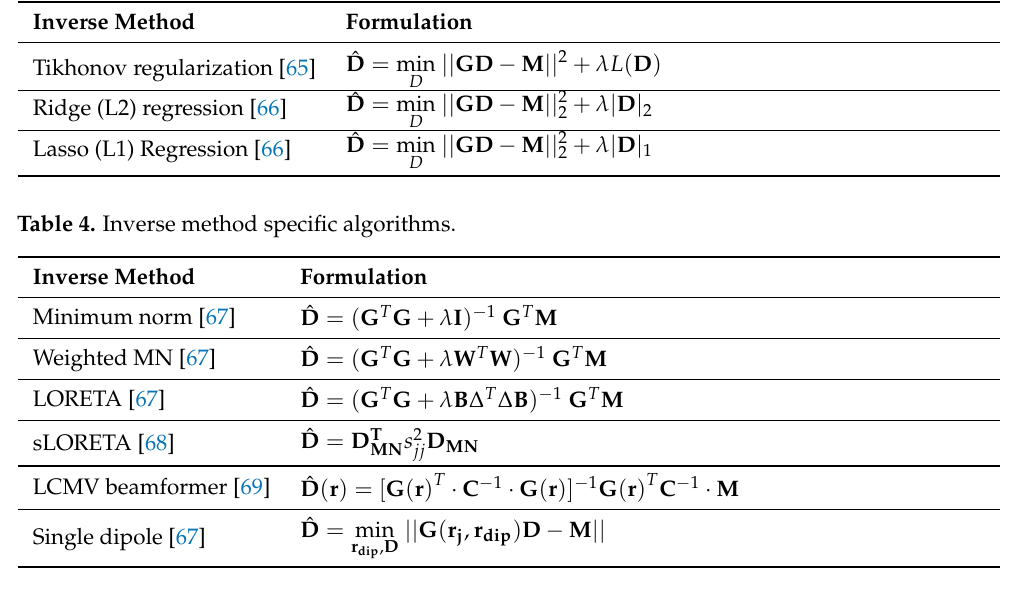
Table 3. Inverse method fundamentals.